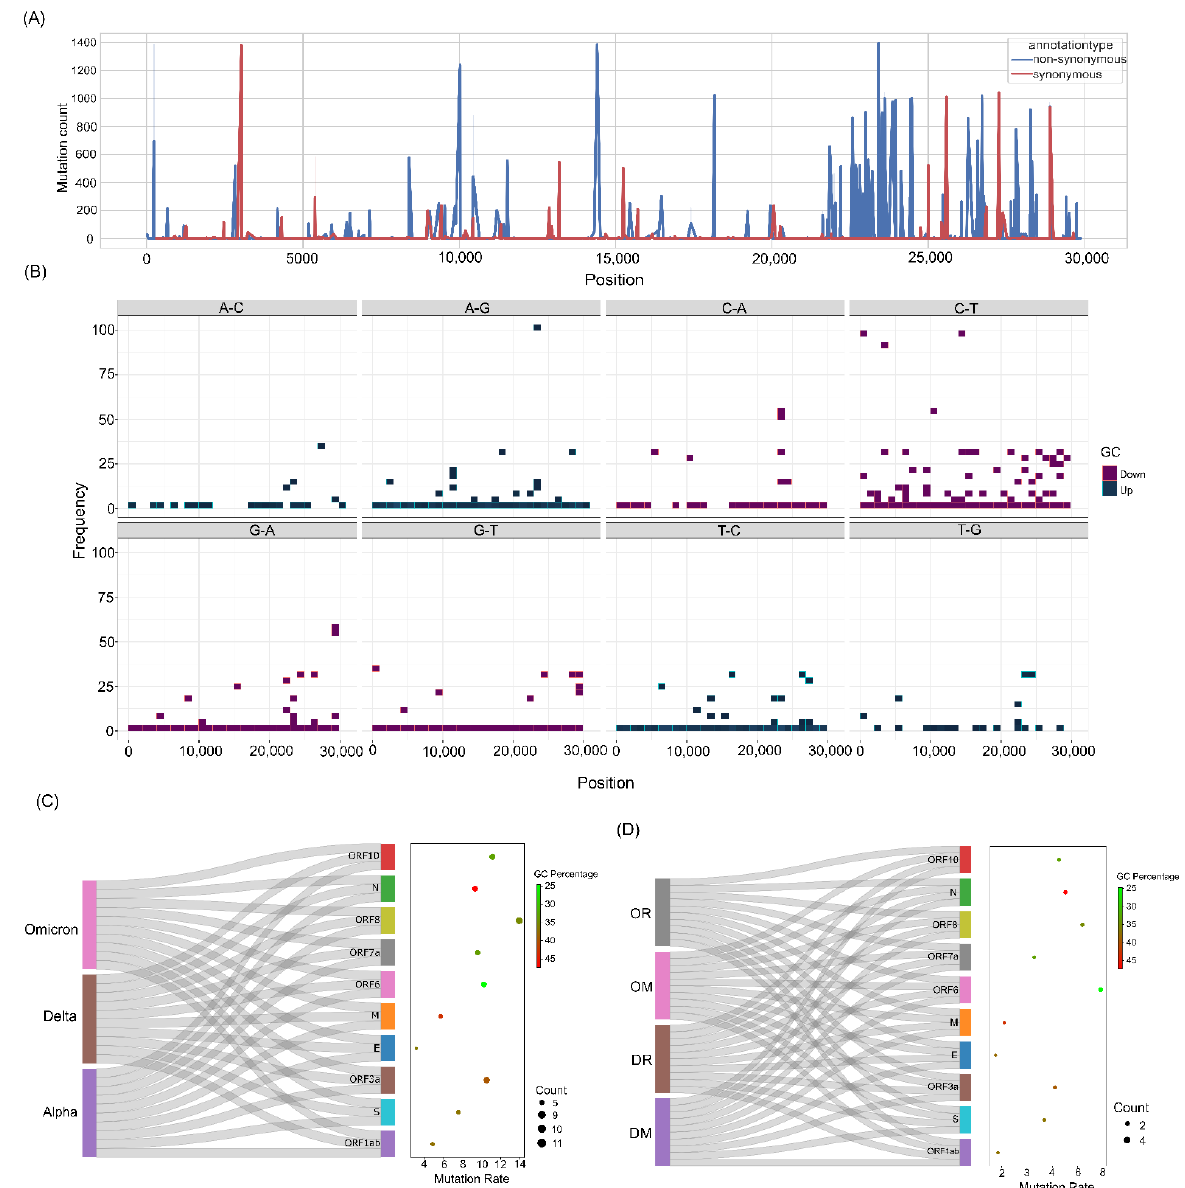
Figure 3. Mutation spectra of the samples and their correlation with GC percentage. ( A ) Synony- mous and nonsynonymous mutation distribution across all the samples. ( B ) GC-up and GC-down mutations in the SARS-CoV-2 genomes. ( C ) Correlation of GC percentage and the mutation rate at the lineage level — Alpha, Delta, and Omicron. ( D ) Correlation of GC percentage and mutation rate in the clinical outcome groups — DR, DM, OR, and OM.